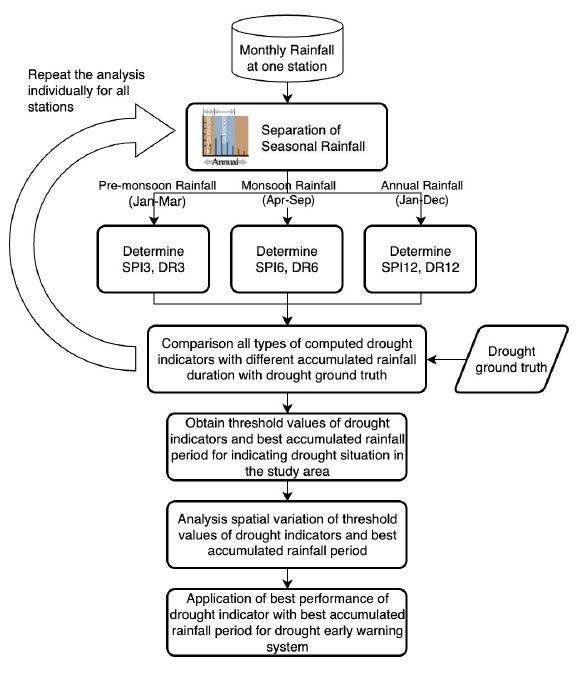
Fig. 1. Methodology to determine appropriate values of drought indicators corresponding to drought